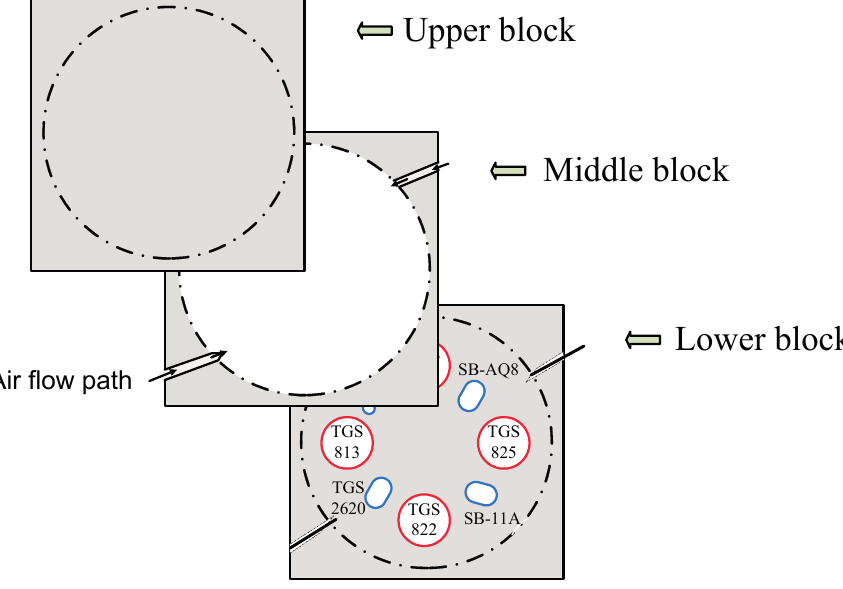
Figure 1. Schematic diagram of the arrangement of three Teflon blocks used for making the gas sensor